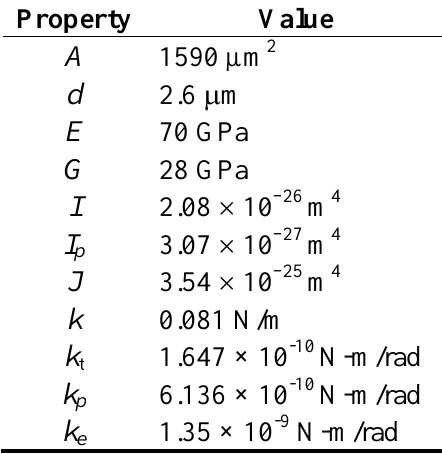
Table 2. Material and geometric properties in the